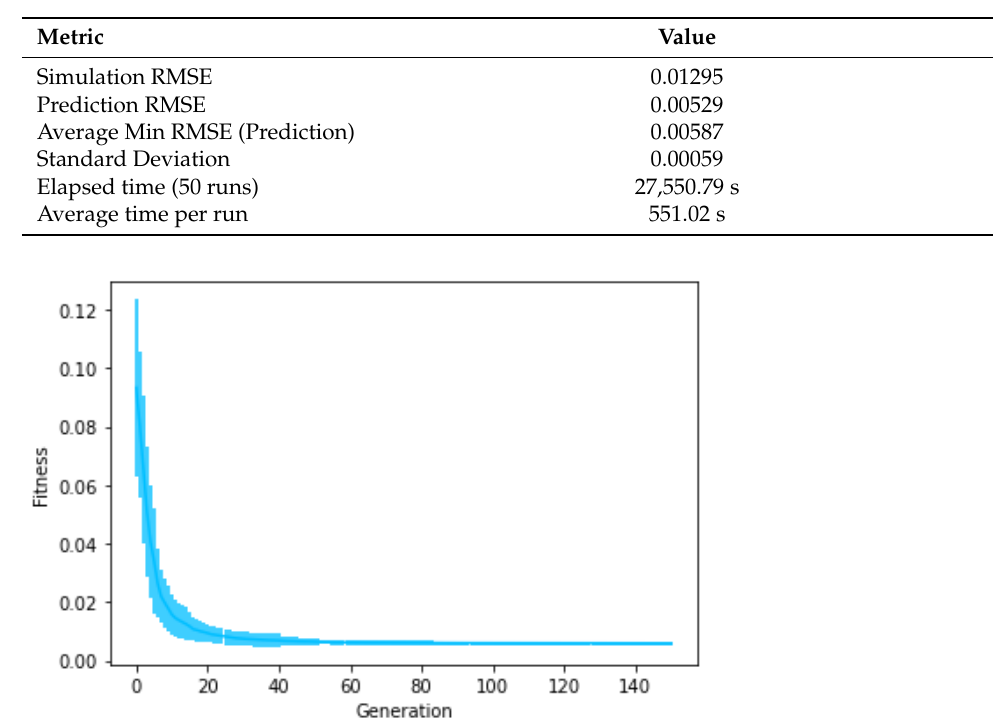
Table 7. Experimental results from the Silverbox problem.